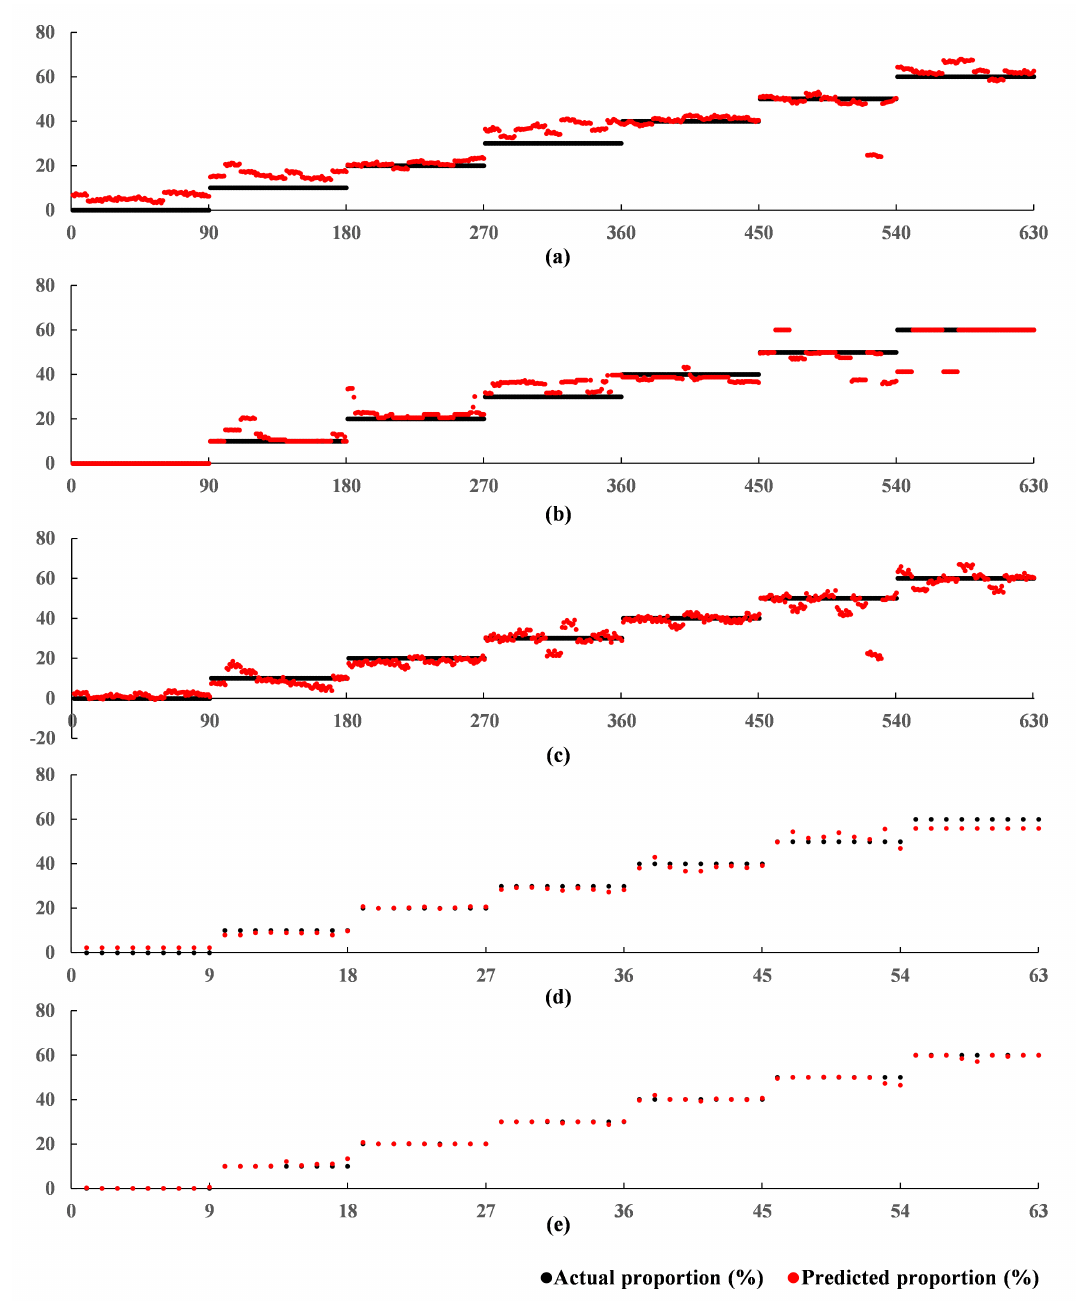
Figure 7. Relationships between the predicted adulterated proportions of the five models and the actual adulterated proportions in Experiment A: ( a ) SVR; ( b ) RFR; ( c ) BPNN; ( d ) 1DCNN; ( e )